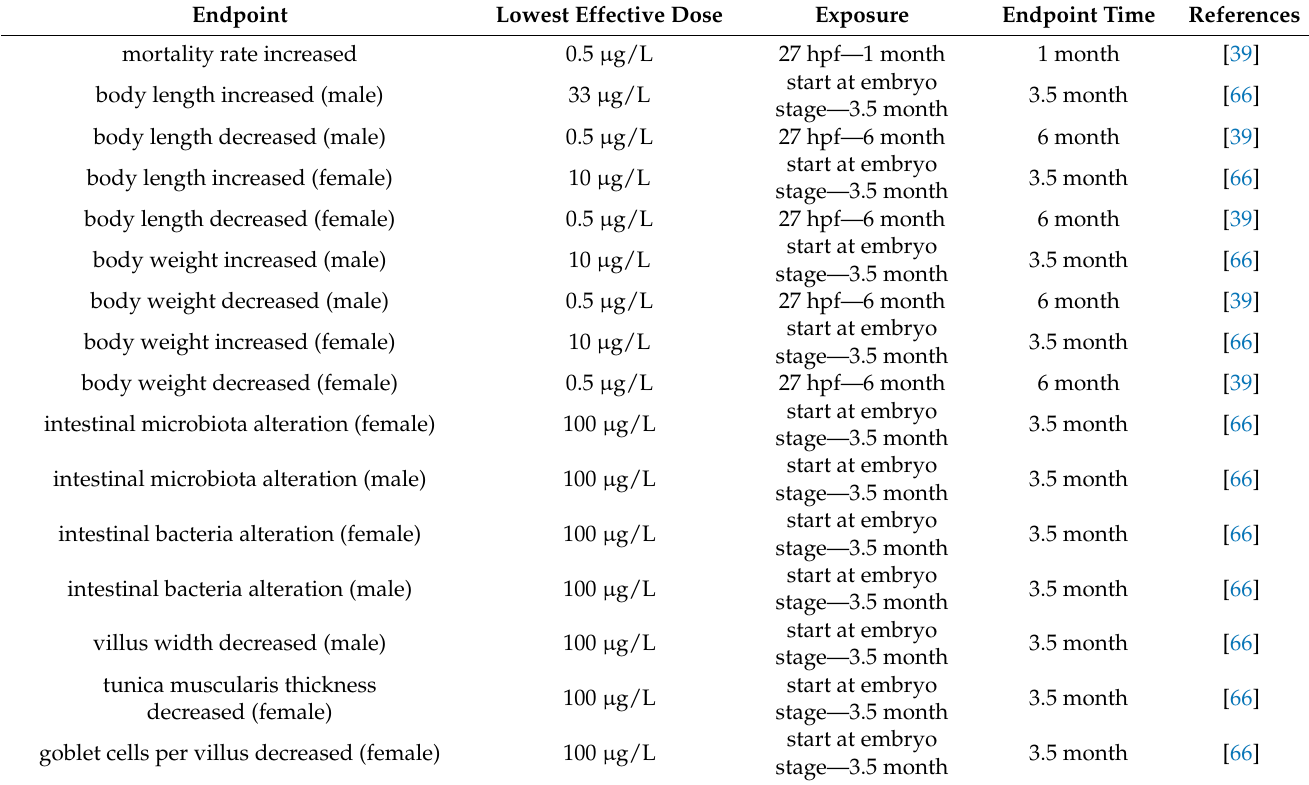
Table 11 summarizes the effects from chronic exposure to DEHP on zebrafish embryos. Table 11. Effects from chronic exposure to DEHP on zebrafish